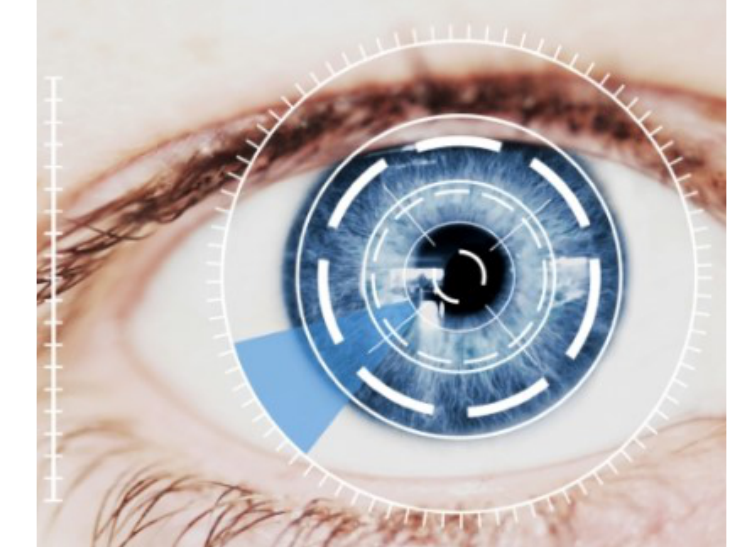
Figure 3 – Iris recognition in biometrics (Burt,